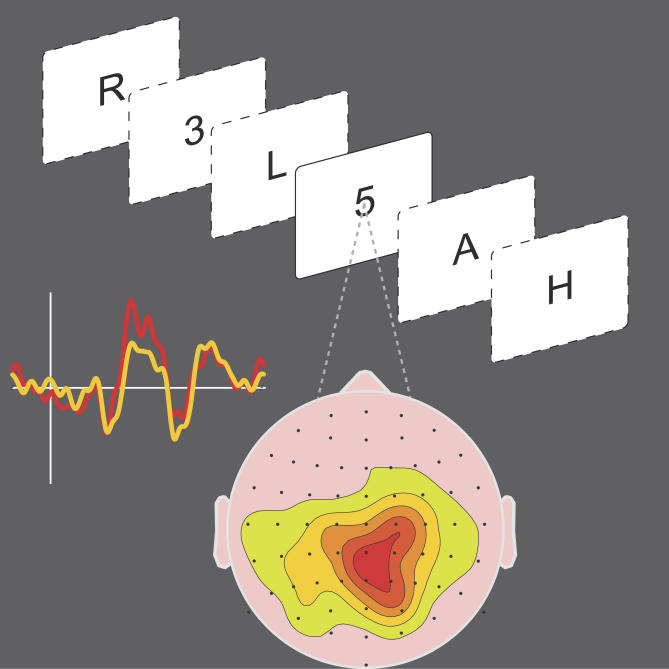
This image depicts the scalp sites where the reduction in brain-resource allocation to the first of two target stimuli (T1) observed after intensive meditative training was significant. The waveforms represent T1-evoked brain potentials as measured at time 1 (red line) and time 2 (orange line).